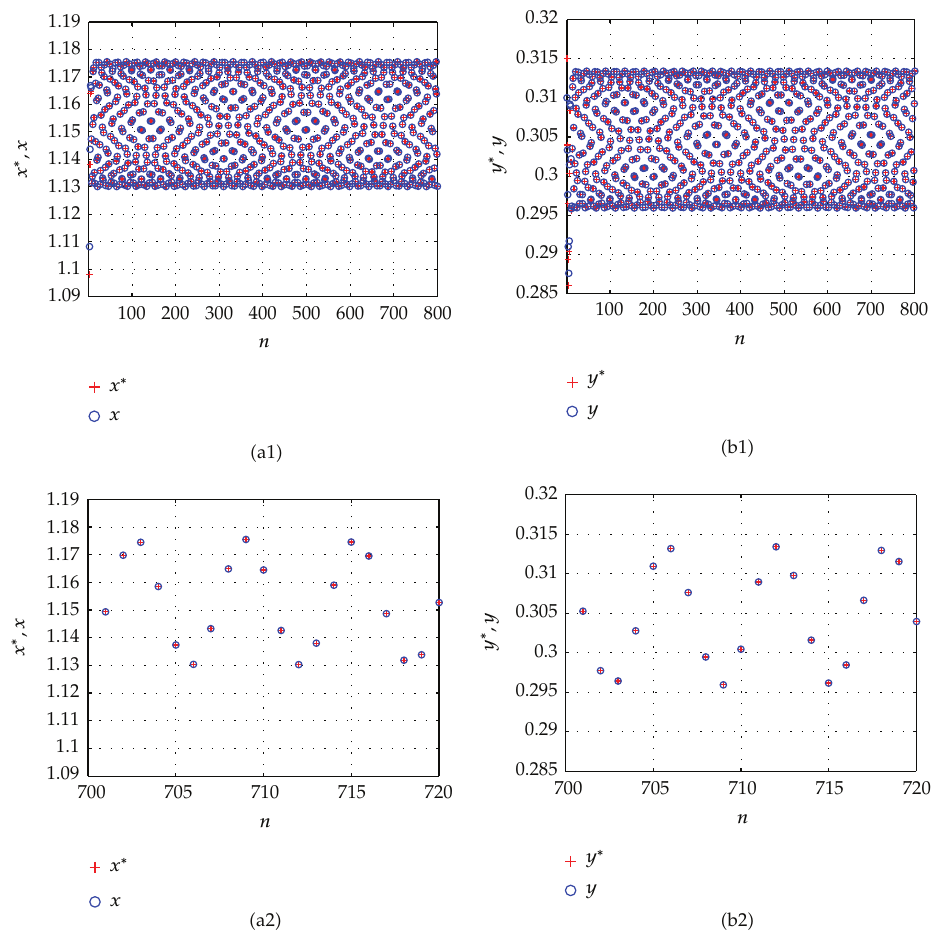
Figure 2: Dynamic behaviors of (cid:3) 1.9 (cid:4) with di ff erent initial values. (cid:3) a1 (cid:4) and (cid:3) a2 (cid:4) show x ∗ ,x with x ∗ (cid:3) − 1 (cid:4) (cid:5) 1 . 06, x ∗ (cid:3) 0 (cid:4) (cid:5) 1 . 0, x (cid:3) − 1 (cid:4) (cid:5) 1 . 04, x (cid:3) 0 (cid:4) (cid:5) 1 . 03 for k ∈ (cid:8) 0 , 800 (cid:9) and k ∈ (cid:8) 700 , 720 (cid:9) , respectively. (cid:3) b1 (cid:4) and (cid:3) b2 (cid:4) show y ∗ ,y with y ∗ (cid:3) − 1 (cid:4) (cid:5) 0 . 32, y ∗ (cid:3) 0 (cid:4) (cid:5) 0 . 315, y (cid:3) − 1 (cid:4) (cid:5) 0 . 315, y (cid:3) 0 (cid:4) (cid:5) 0 . 31 for k ∈ (cid:8) 0 , 800 (cid:9) and k ∈ (cid:8) 700 , 720 (cid:9) ,